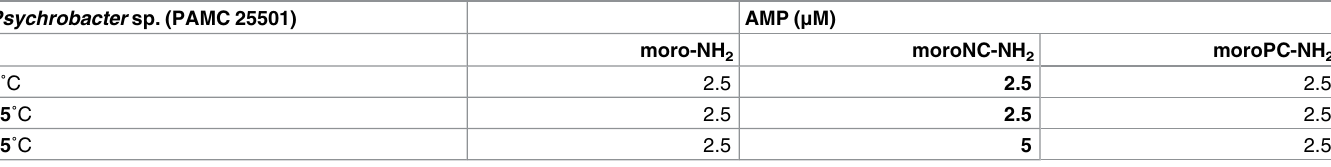
Table 4. Effect of temperature on AMP activity against Psychrobacter sp. PAMC 25501. Psychrobacter sp. (PAMC